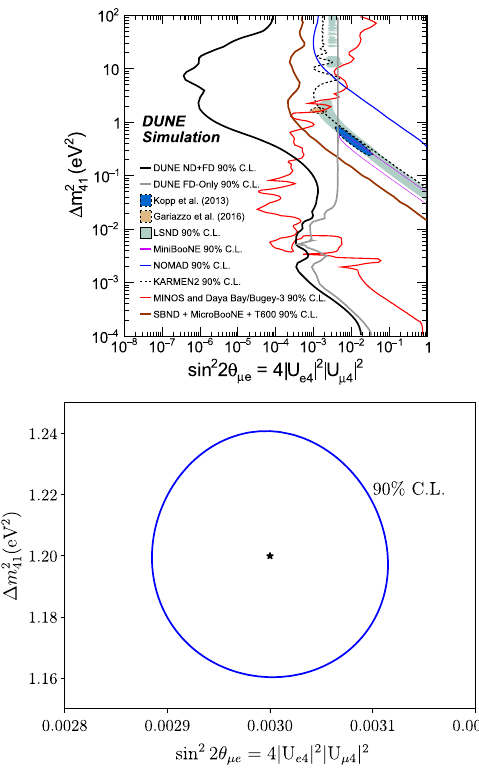
Fig. 4 DUNE sensitivities to θ μ e from the appearance and disappear- ance samples at the ND and FD are shown on the top plot, along with a comparison with previous existing experiments and the sensitivity from the future SBN program. Regions to the right of the DUNE contours are excluded. The plot is adapted from Ref. [18]. In the bottom plot, the ellipse displays the DUNE discovery potential assuming θ μ e and Δ m 2 set at the best-fit point determined by LSND [19] (represented by the star) for the best-case scenario referenced in the